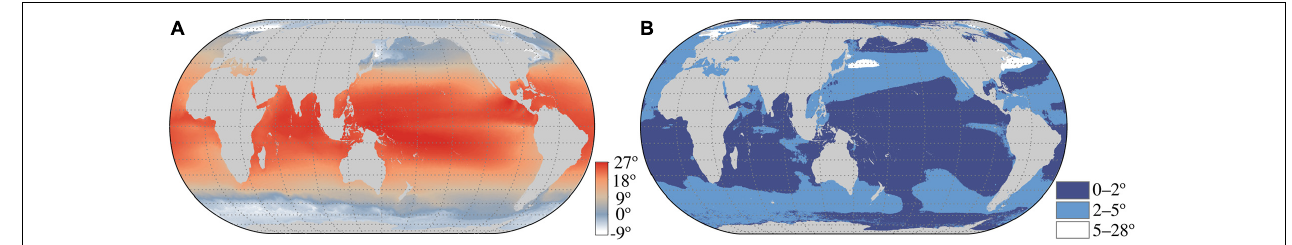
FIGURE 2 | Pleistocene glacial sea surface temperature (SST) during the coldest month of the year (A) , and the temperature difference between current SST and Pleistocene LGM SST (B) . Data shown is the SST from the coldest ice-free month from the MARSPEC database (Sbrocco and Barber, 2013) plotted using a Robinson projection in ArcMap v10.8.1